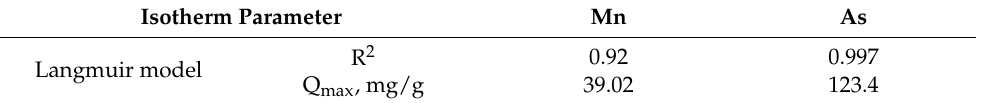
Table 1. Adsorption isotherm parameters for the adsorption of Mn and As on DMAPAAQ + FeOOH. Isotherm